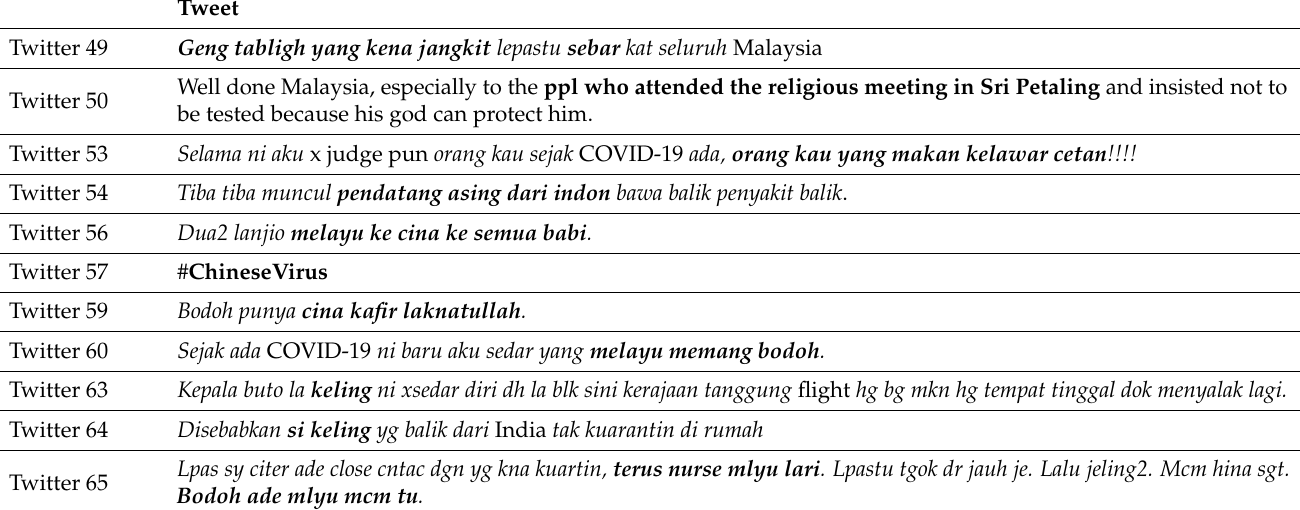
Well done Malaysia, especially to the ppl who attended the religious meeting in Sri Petaling and insisted not to be tested because his god can protect